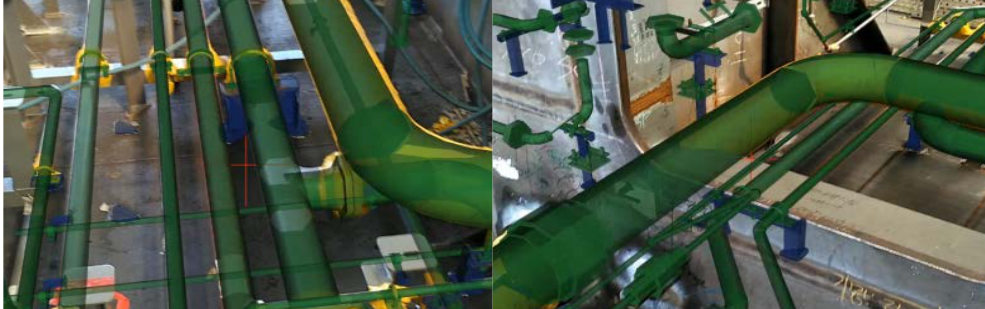
Figure 15. Examples of accurate AR scene generation. The pipe and pipe support CAD models are augmented very precisely on the real objects.